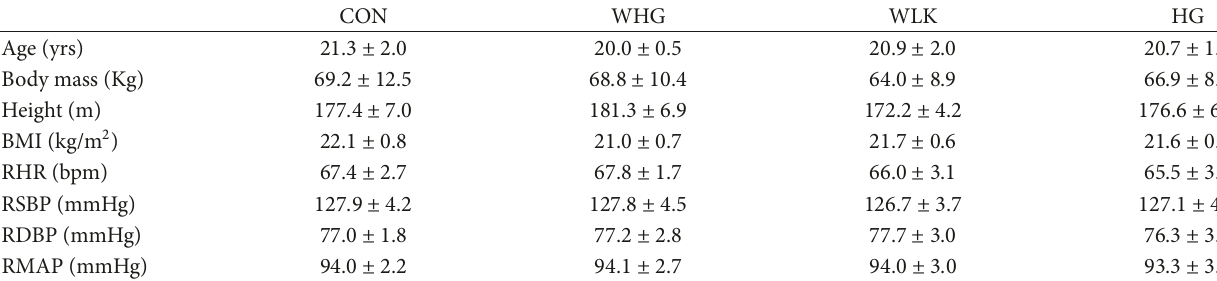
Table 1: Control and trained groups resting baseline data.